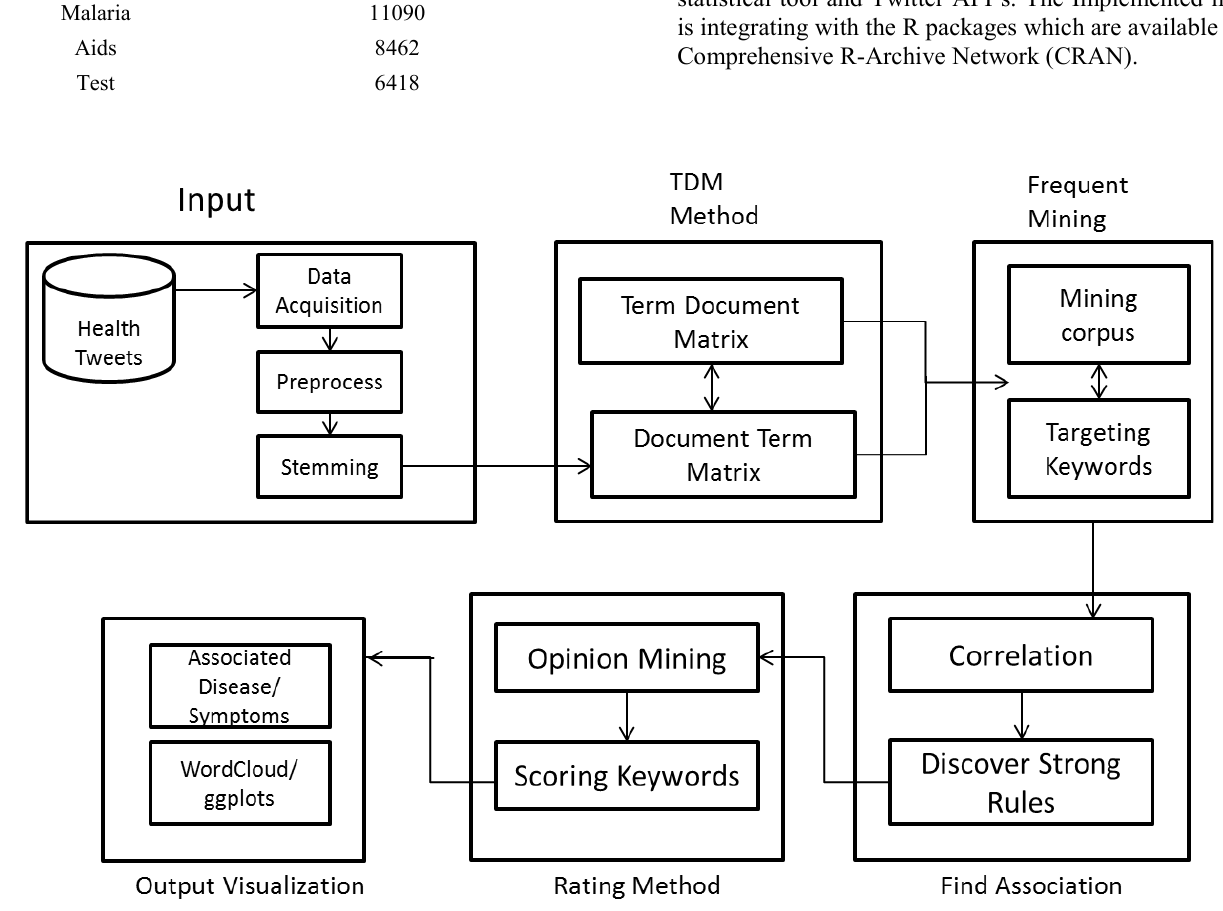
Figure 1. Flow of the proposed Work using Fuzzy Association